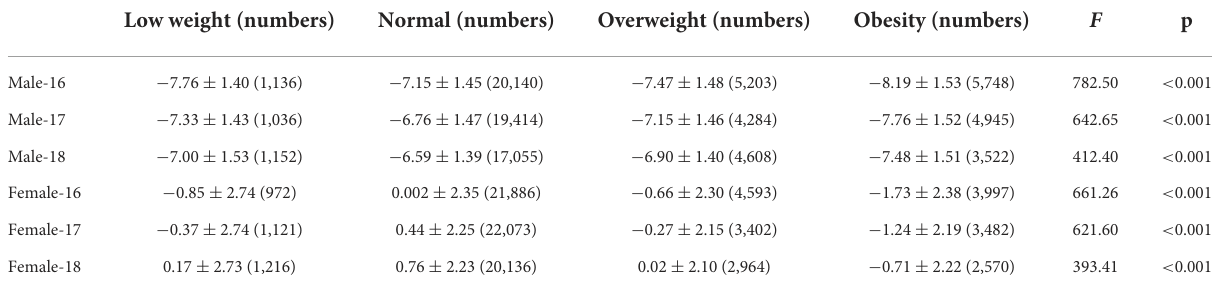
TABLE 2 The PFI of participants grouped by gender, BMI, and